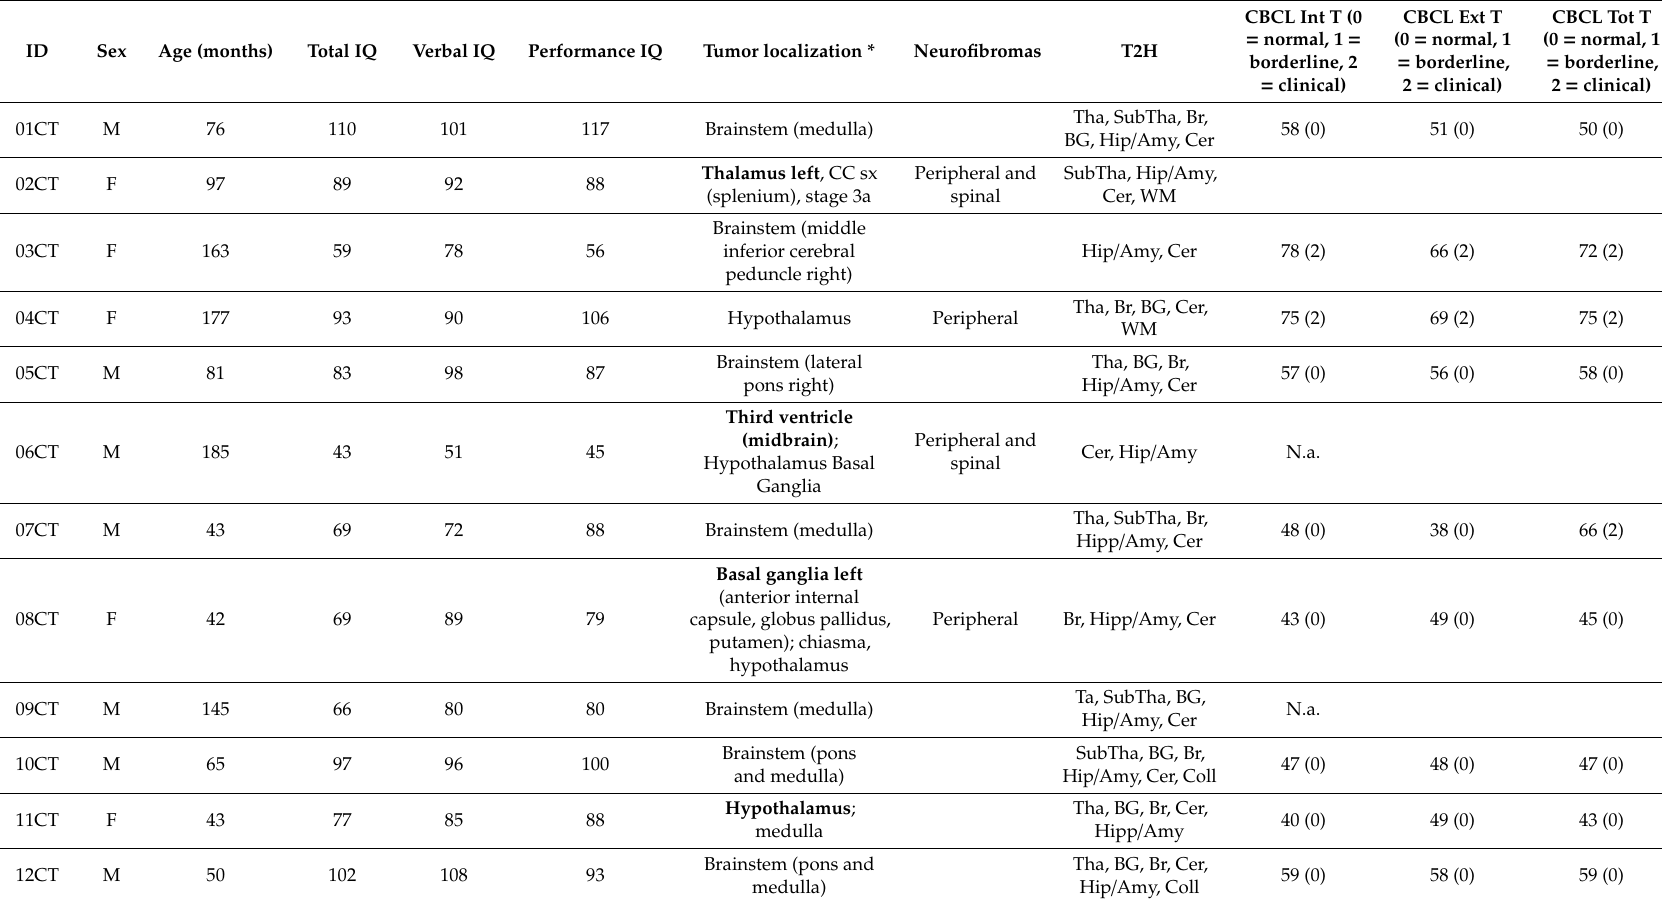
Table 5. Clinical characteristics of patients with NF1 and extra-optical pathways brain